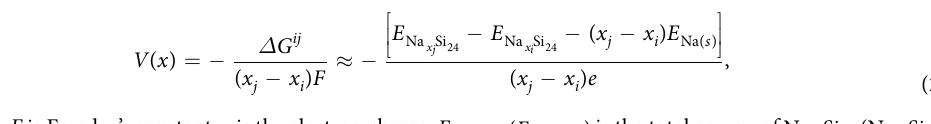
(Fig. 2(a)). Our computed average voltage between the fully sodiated ( x = 4) and desodiated ( x = 0) phases is 0.30 V. In addition, we predict a small voltage jump of 0.11 V at x = 0.5, which corresponds to the formation of the intermediate Na 0.5 Si 24 structure. These results are consistent with the intercalation potentials reported by Marzouk et al . 43 for Na 1 Si 24 , Na 2 Si 24 , Na 3 Si 24 , and Na 4 Si 24 . In particular, their average voltage considering these four structures is also ~0.30 V.